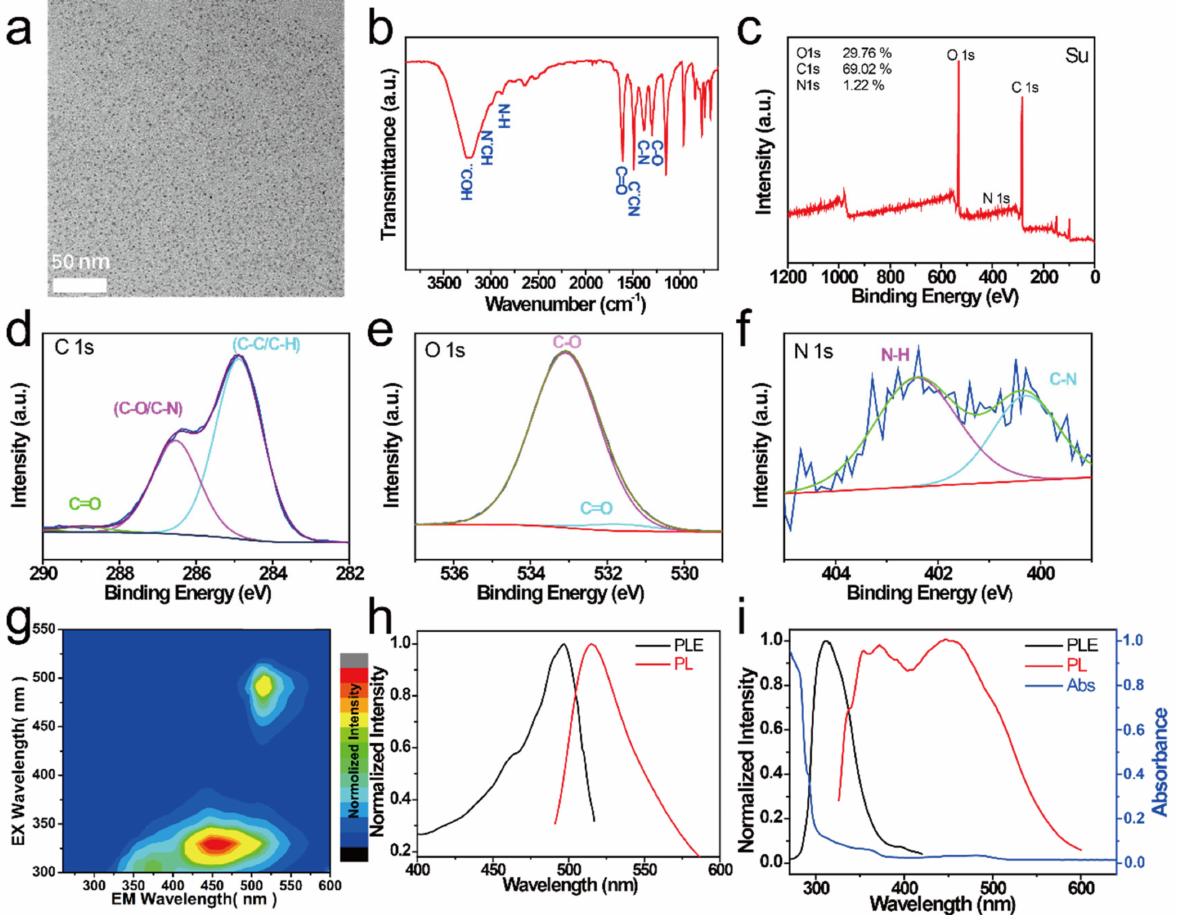
Figure 1. ( a ) TEM image, ( b ) FT–IR spectrum, and ( c ) XPS spectrum of NCDs. ( d ) Corresponding high-resolution C 1s spectra, ( e ) O 1s spectra, and ( f ) N 1s spectra of NCDs. ( g ) Excitation–emission color 3D map of NCDs. ( h ) Excitation (black curve) and fluorescence (FL) spectra (red curve) of NCDs (311 nm excitation). ( i ) Absorption (blue curve), excitation (black curve), and fluorescence (FL) spectra (red curve) of NCDs (497 nm